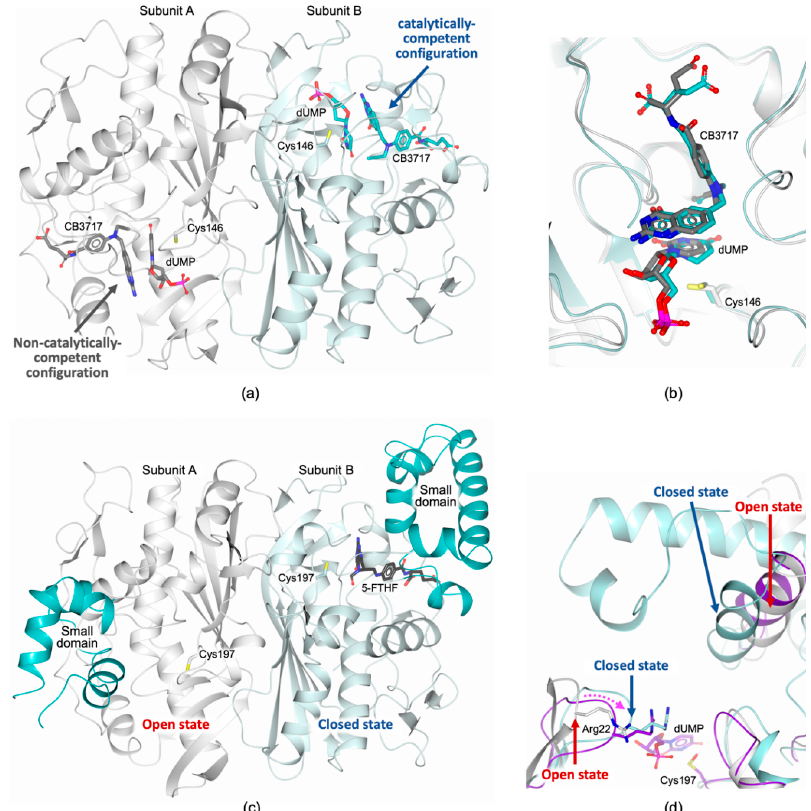
Figure 4. ( a ) Cartoon representation of Ec TS I264Am homodimer (Subunits A and B are colored white and light turquoise, respectively; dUMP and CB3717 are shown in sticks, color coded according to the subunit; PDB id 6CDZ [19]). In the active site of Subunit B, the substrate and the cofactor-like inhibitor CB3717 are correctly aligned to mimic a catalytically-competent configuration. On the contrary, in the partner protomer the two molecules assume a non-catalytically-competent configuration. The induced asymmetry, generated in the Ec TS dimer, supports the half-site reactivity of the enzyme. ( b ) Active site view of the superimposition between the catalytically-competent configuration and the non-catalytically-competent configuration of Ec TS I264Am homodimer. ( c ) Cartoon representation of the Ef TS homodimer (Subunits A and B are colored white and light turquoise, respectively, the SD is colored turquoise in both subunits; PDB id 3UWL [16]). The Ef TS homodimer is highly asymmetric. Subunit B is in the closed conformation, having the catalytic cavity fully formed, whereas the partner protomer is in the open form, showing a widely unstructured active site. The cofactor analogue 5-formyl-tetrahydrofolate, 5-FTHF (in sticks, black carbons), is entrapped in the active site of Subunit B ( d ) Active site view of the superimposition between the open (white cartoon and carbons) and the closed (light turquoise cartoon and carbons) states of Ef TS (PDB id 3UWL [16]) and the Ef TS–dUMP complex (purple cartoon and carbons; Cys197 is modified as S-oxycysteine; PDB id 6QYA [41]). dUMP binding in open-state subunits induces the closure of the substrate site (indicated by a dashed pink arrow), whereas cofactor binding is required to fully structure the catalytic cavity. The movement of loop 18–26, determining the closure of the substrate site, is evidenced by the shift of Arg22 (in